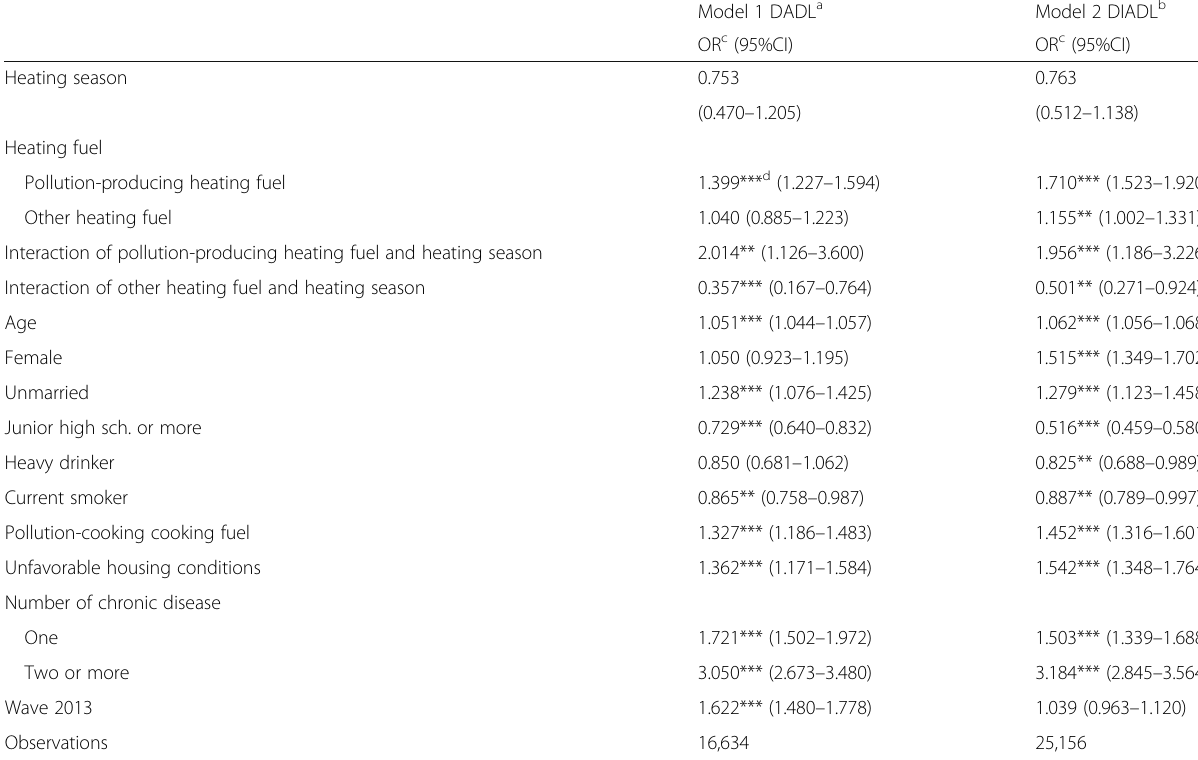
Table 2 Multiple regression analysis of associations between household heating and disability for activities of daily living in random effects logit